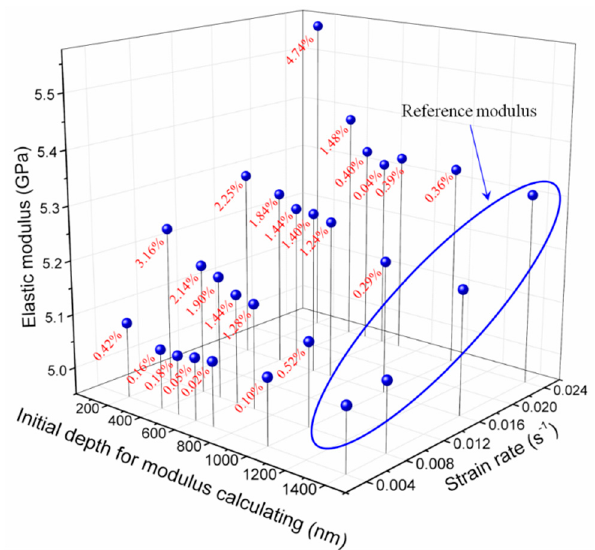
Figure 11. Three-dimensional plots of the relationship of elastic modulus against strain rate and depth range.